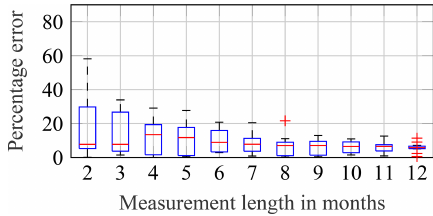
Figure 23. Convergence of the percentage error of predicted yearly damage values using the binning approach for increasing measure- ment lengths. Box plot shows data from 13 different measurement periods.